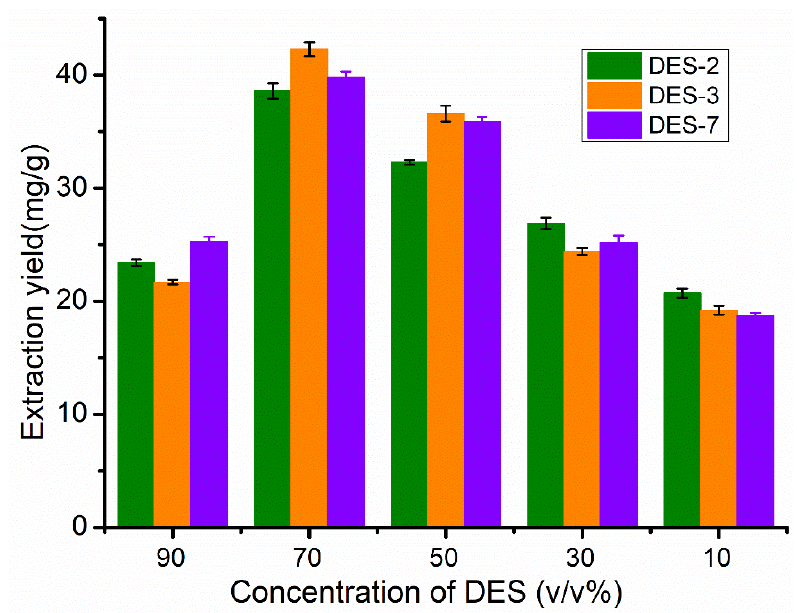
Figure 3. Extraction yield of flavonoids in the three DESs (DES-2,3,7) with different concentrations via ultrasound-assisted extraction with solvent/solid ratio of 30/1 at 28 °C for 30 min.